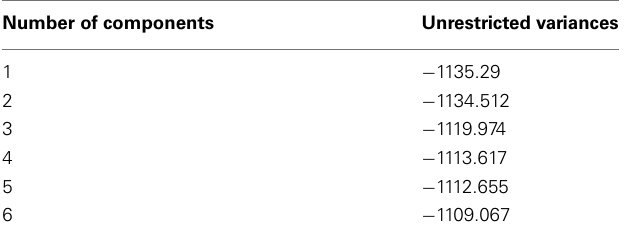
Table 1 |Value of the log of the likelihood for the mixture components.